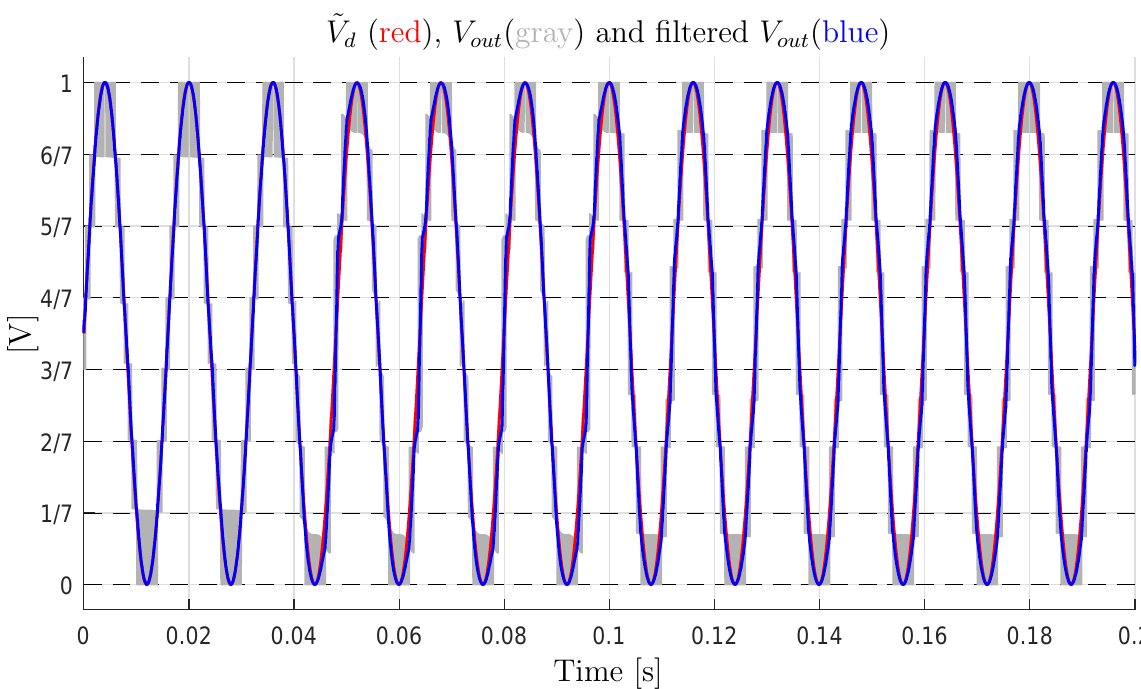
Figure 23. Deformation of the output voltage waveform in the extended operation of the converter with the Configuration Voltage Vector V m = [ 7 6 2 ] T caused by the voltage trajectory divergence in presence of a sudden load